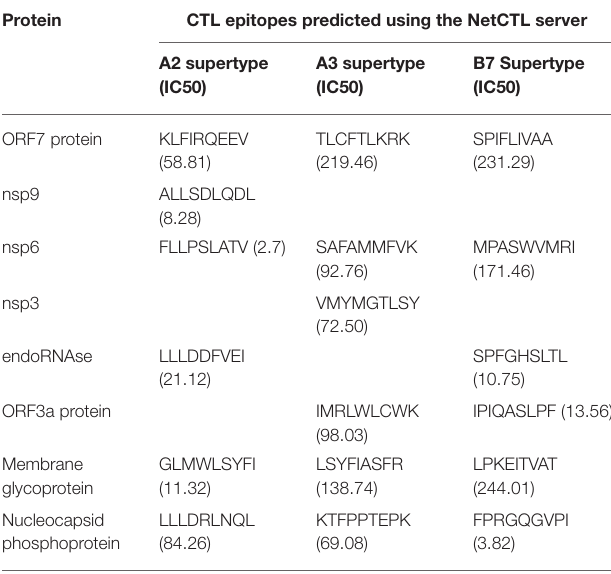
TABLE 2 | Predicted cytotoxic T lymphocyte (CTL) epitopes of SARS-CoV-2 proteins utilized for the construction of a multi-epitope subunit vaccine. Protein